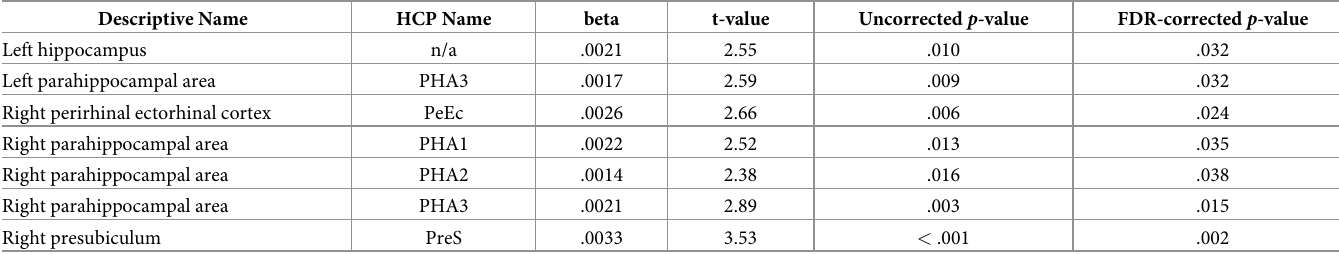
Table 4. Brain regions’ node strength significantly associated with non-verbal episodic memory test